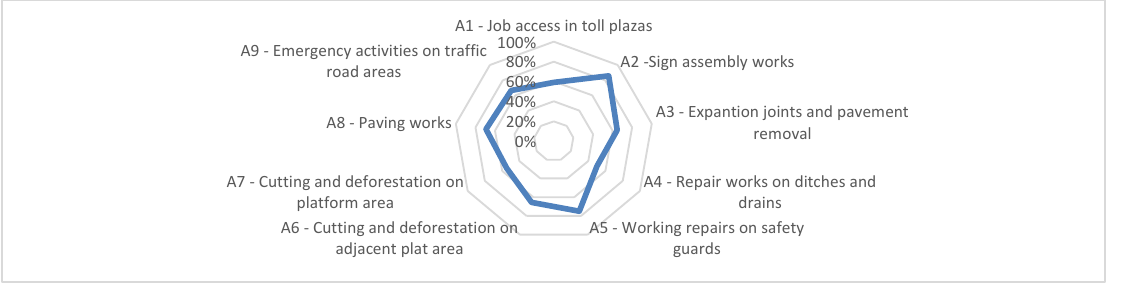
Figure 7. General prevention principles and associated to the work conception and